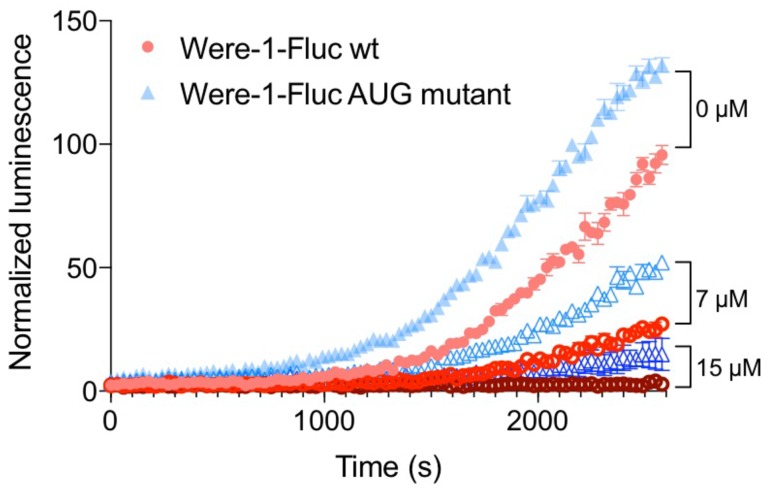
The effect of the canonical start codon on Were-1-Fluc expression in vivo.Comparison of luciferase expression (± SEM) of Were-1-Fluc wild-type (wt; red) and Were-1-Fluc containing an AUG start codon (Were-1-Fluc AUG mutant; blue), in place of the pool-derived UUG minor start codon, with increasing amino-tSS concentrations. Bioluminescence was overall higher in the Were-1-Fluc AUG mutants for all conditions but retained the wt dose-dependent response.Figure 2—figure supplement 5—source data 1.Comparison of protein expression by amino-tSS in Were-1 variants containing UUG or AUG start codon.